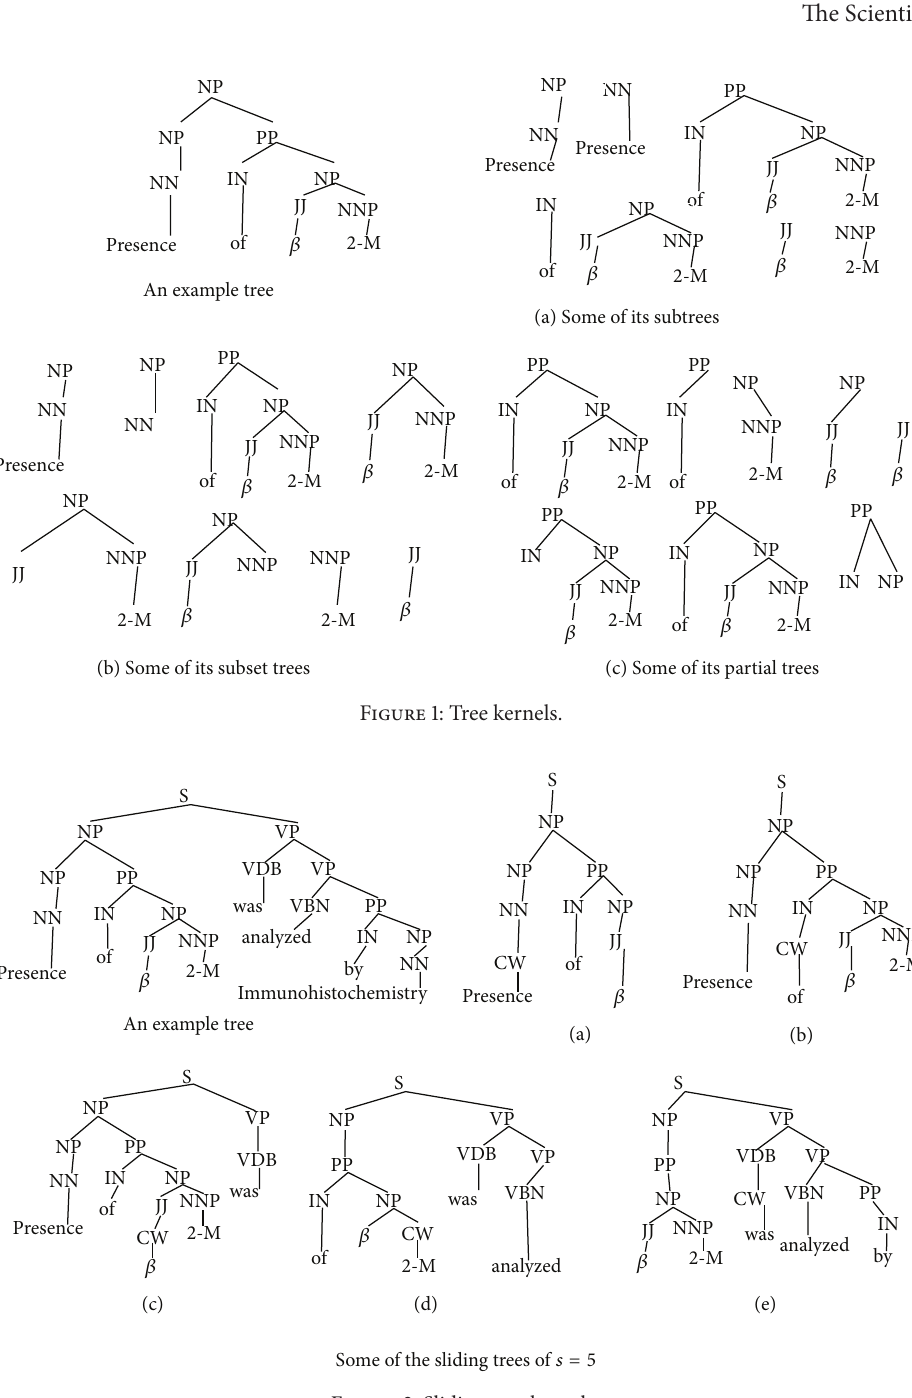
Figure 2: Sliding tree